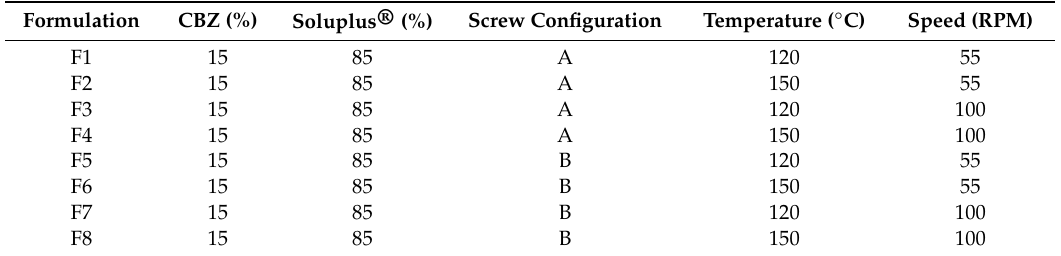
Table 1. Design of experiment (DOE) formulations design